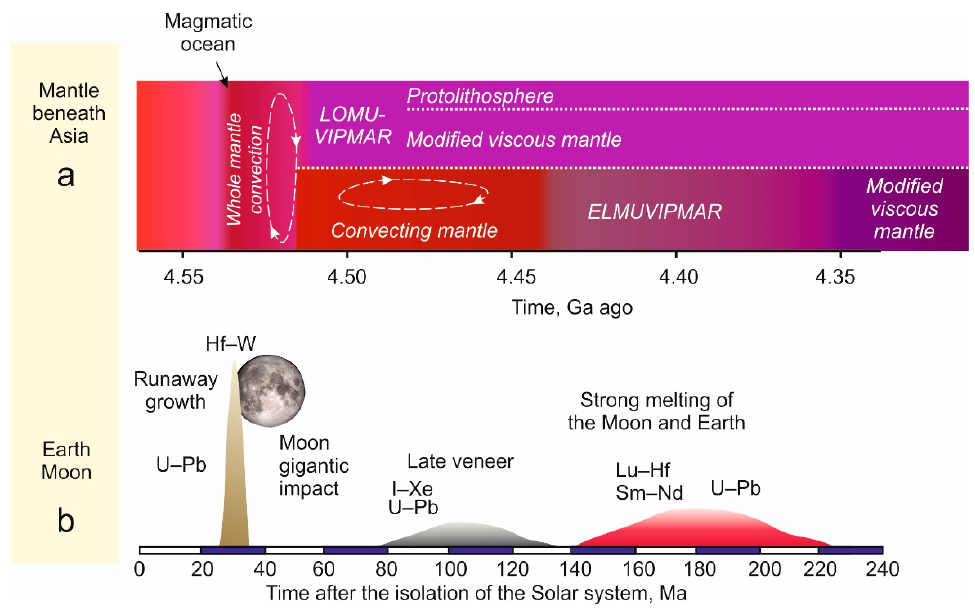
Figure 13. Generation of the LOMUVIPMAR at 4.51 Ga ago and later maintaining of low viscosity that provides the ELMUVIPMAR generation beneath Asia ( a ) in the context of the early Earth events ( b ). In panel ( b ), sequence of events is shown after [35,136,137,138].